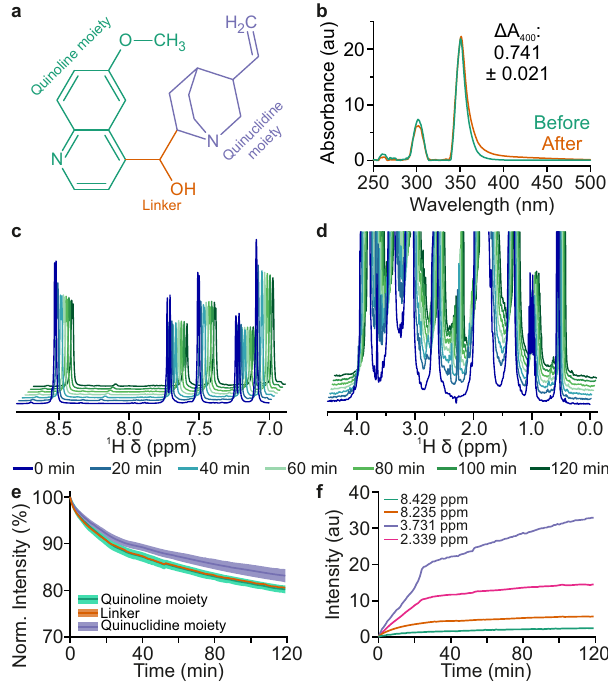
Fig. 5 Photodegradation of quinine by UV irradiation using 10 W LED array with peak emission at 365 nm. a Chemical structure of quinine, with chemical moieties indicated. b UV/Vis absorbance spectrum of quinine before and after 2 h UV irradiation in NMRtorch tube. c Reduction in 1 H NMR signals from quinoline moiety upon in situ UV illumination, monitored continuously. d Changes in aliphatic 1 H NMR signals, including appearance of new peaks and spectral broadening. e Quinine signal intensity reduction over time, with each signal normalised against initial value. Shaded regions represent parameter error estimates with 95% con fi dence intervals. f Growth of degradation product signals over